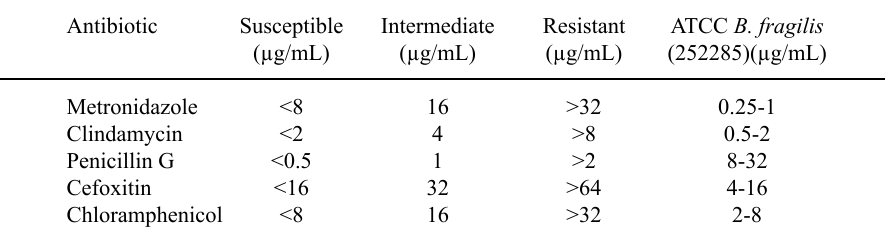
Table 3. Antimicrobial susceptibility profile of P. anaerobius isolates Antibiotic